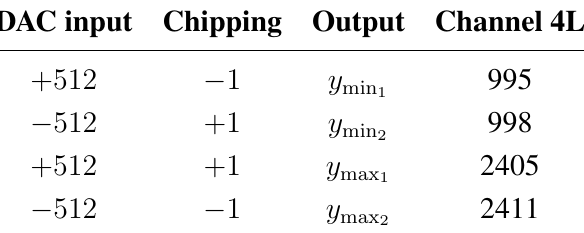
Table 1. Symmetry Characterization Table.